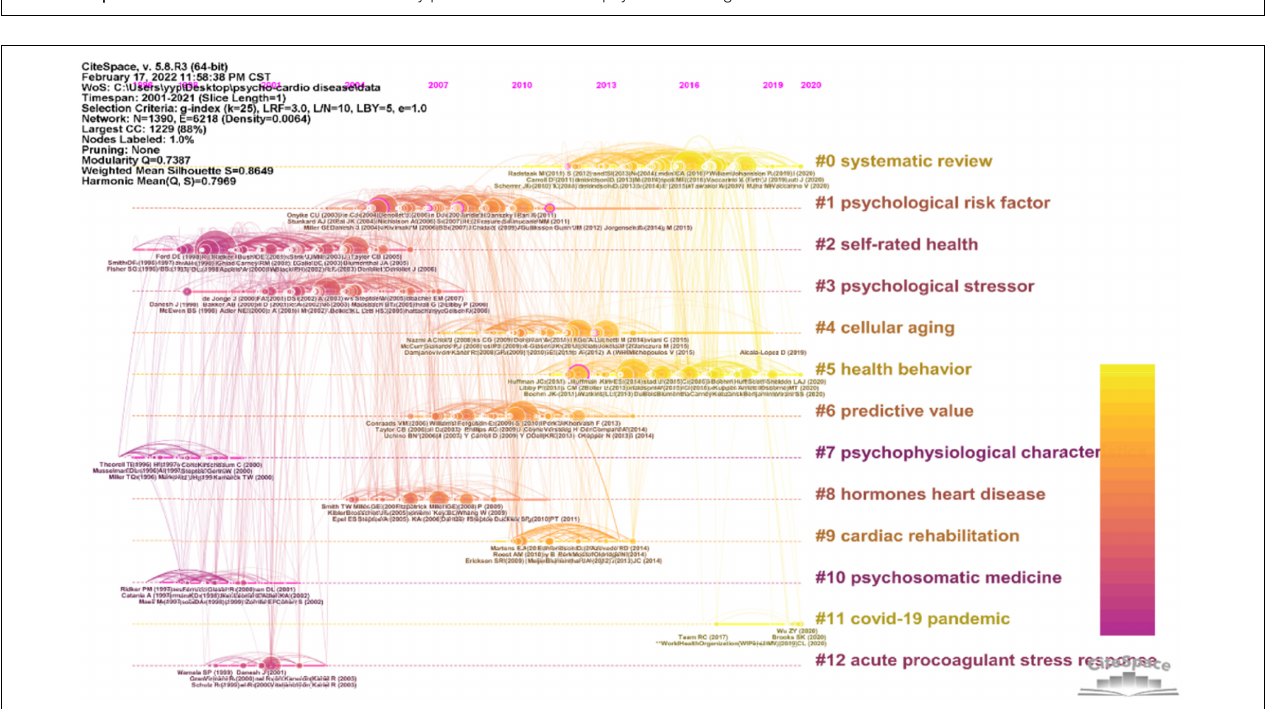
FIGURE 6 | Co-citation network of references cited by publications about the psycho-cardiological disease and related literature.